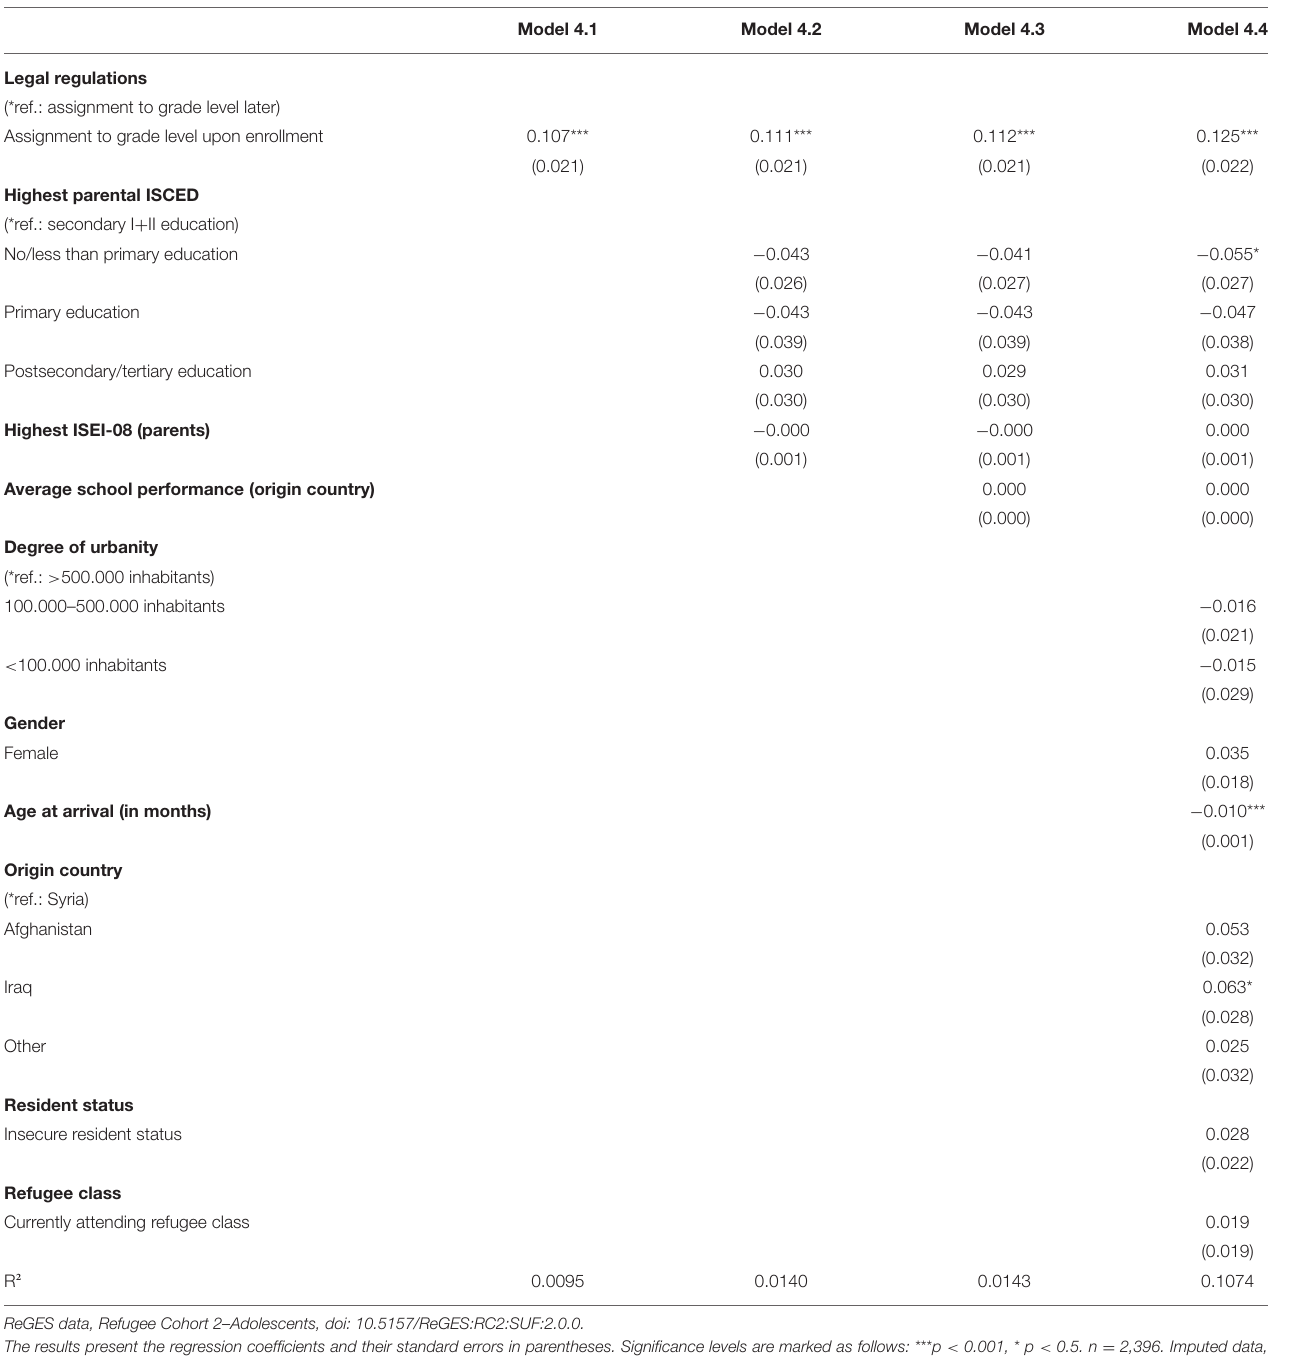
TABLE 9 | Stepwise linear probability models on age-appropriate placement as dependent variable (not age-appropriate placement vs. age-appropriate